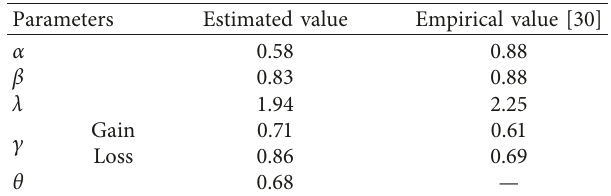
Table 3: Estimated value and empirical value of the parameters in FVDM.